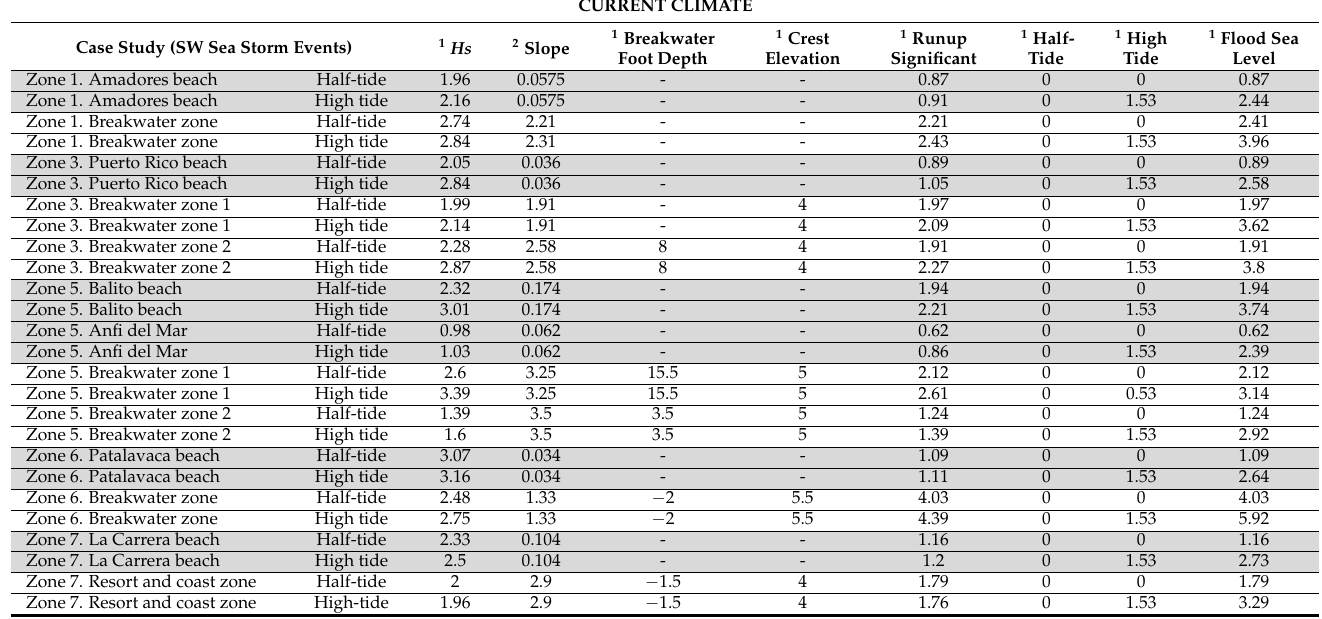
Table 2. Data used to calculate the current flood sea level (last column) in the different zones studied (beaches, grey), and with two situations (half-tide and high tide), when SW marine storms occur (1958–2018).